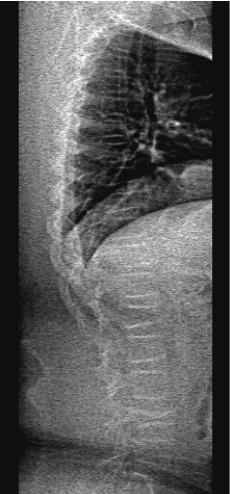
Figure 1: Densitometric lateral spinal imaging obtained at the time of bone density test by DXA shows L1 and L4 compression fracture with a mild anterior wedging of L2 in a 14-year-old boy with DMD. (Film courtesy of Dr. Sasigarn